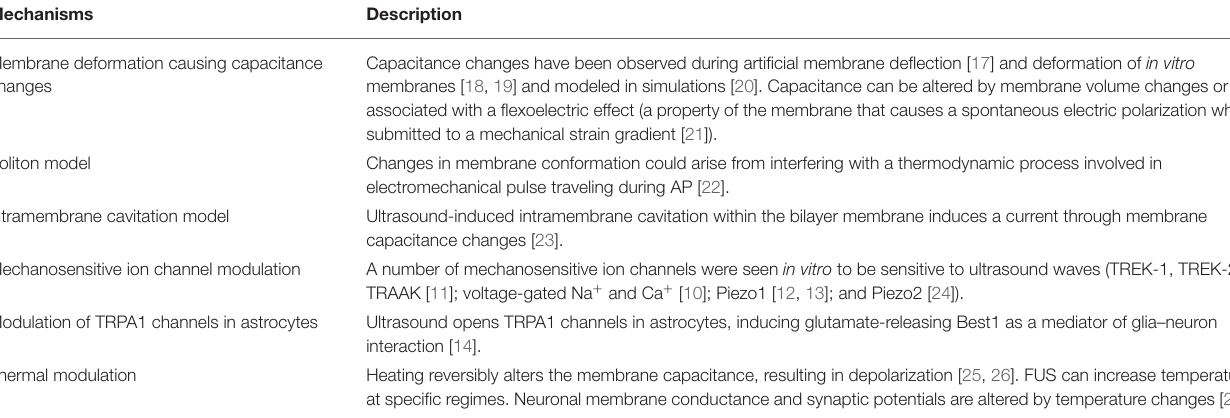
TABLE 1 | Summary of potential mechanisms associated with ultrasound neuromodulation.